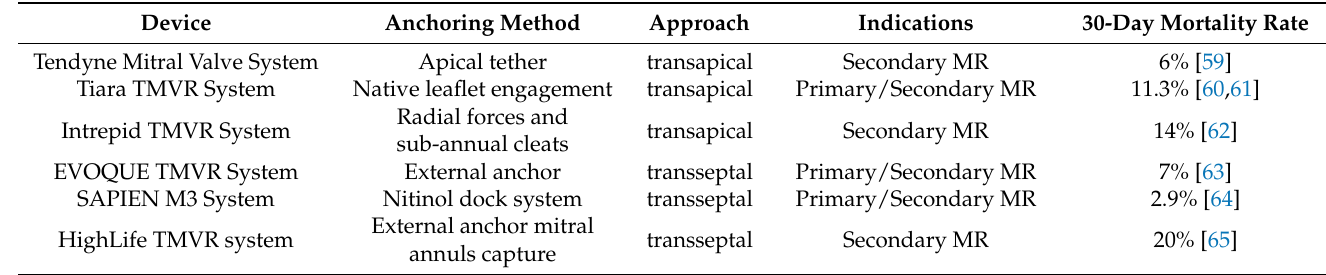
Table 4. Overview of Transcatheter Mitral Valve Replacement Device